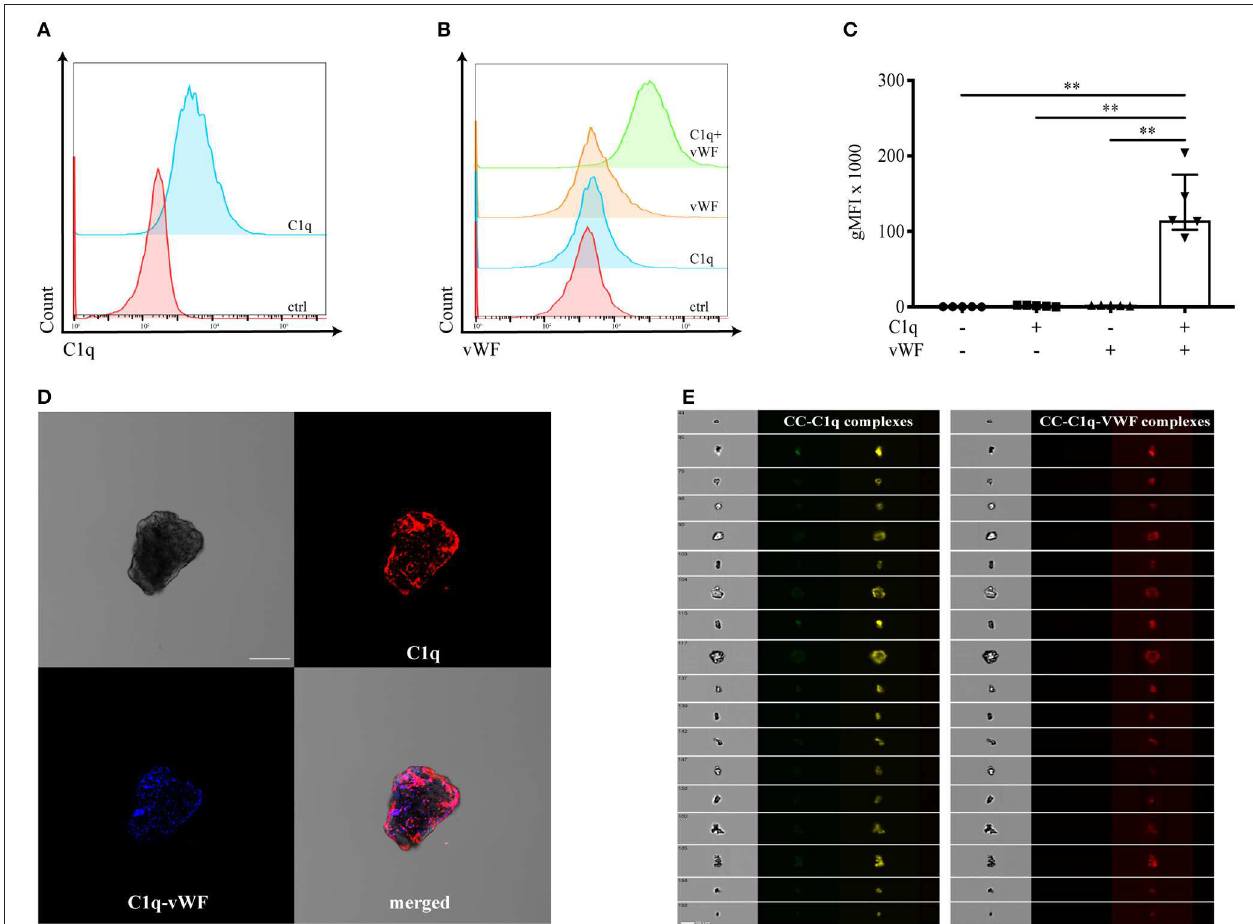
FIGURE 1 | vWF binds to CC in a C1q-dependent manner. Binding of C1q and vWF to surface-bound C1q on CC was determined by (A–C) flow cytometry, (D) confocal microscopy, and (E) ImageStreamX. Representative flow cytometry diagrams show the binding of (A) C1q or (B) C1q-dependent binding of vWF on the surface of CC. Controls (ctrl) represent the presence of secondary antibodies only. (C) Flow cytometry data are shown as median gMFI with IQR ( n = 5, Mann-Whitney U -test, ** p < 0.01). (D) Confocal microscopy depicting a representative CC in brightfield, with C1q (red) or vWF (blue) in the presence of C1q bound to its surface. The merged staining patterns visualize the C1q-vWF interaction. One of three independent experiments is shown. Scale bar = 50 µ m. (E) Fluorescent staining of CC captured by ImageStreamX for C1q (yellow) or C1q-vWF (red). One of two independent experiments is shown. Scale bar = 10 µ m.